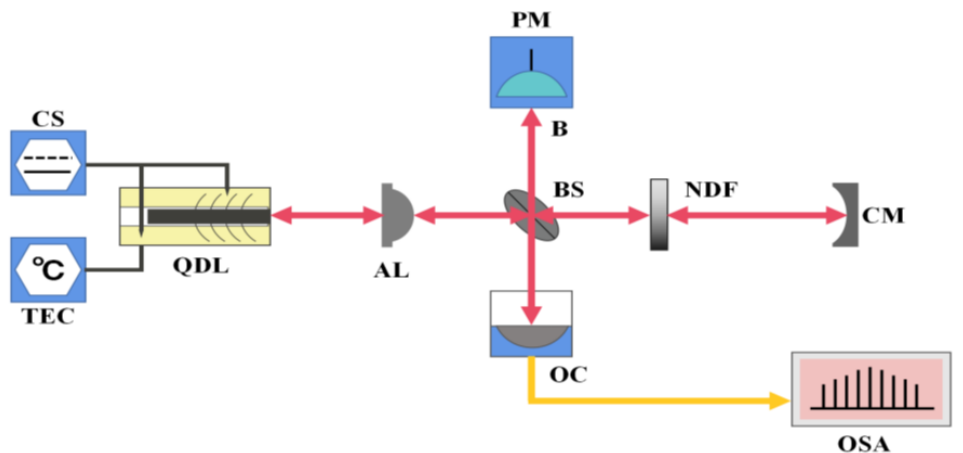
Figure 1. Experimental setup for an ESQDL under concave mirror optical feedback. ESQDL: quantum dot laser; CS: current source; TEC: temperature controller; AL: aspheric lens; BS: beam splitting; PM: power meter; NDF: neutral density filter; CM: concave mirror; OC: output coupler; OSA: optical spectrum analyzer.